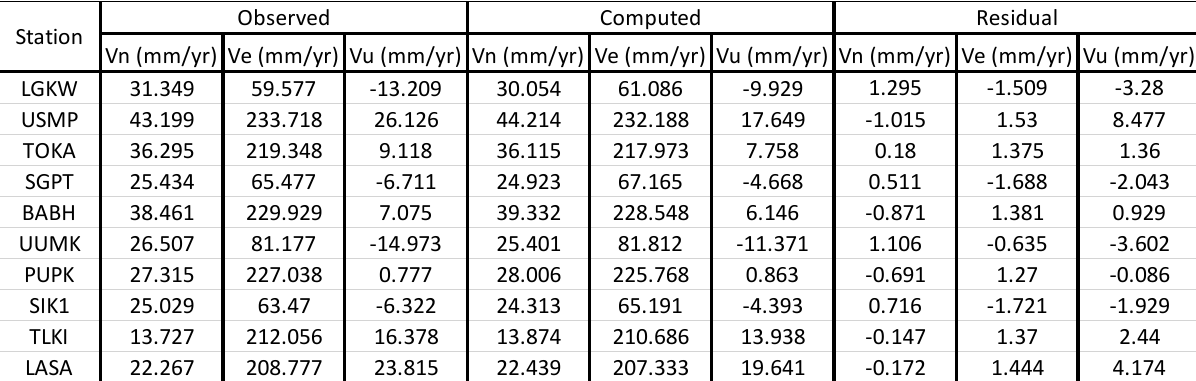
Table 1. The difference between observed and computed velocities for ten (10) sites in Peninsular Malaysia region from year 2012.